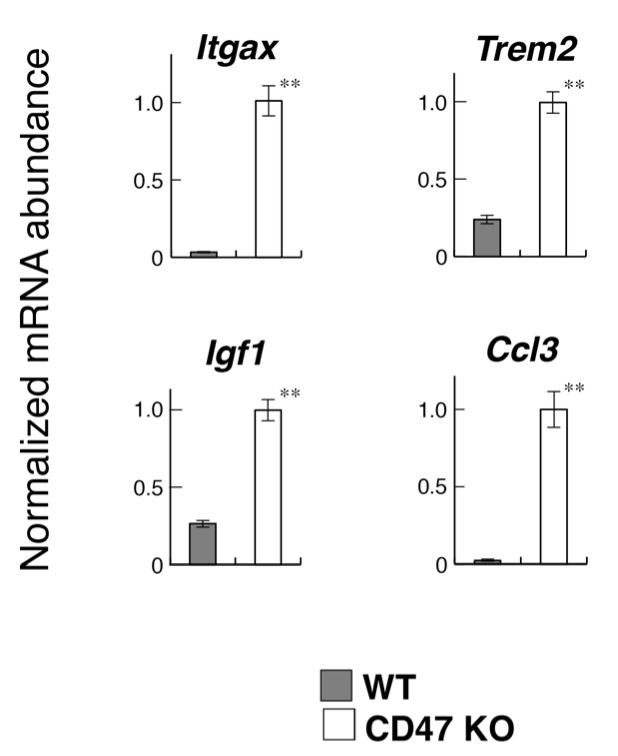
Quantitative PCR analyses of white matter RNA.Total RNA samples from the optic chiasm and optic nerve of CD47 KO and WT mice (n = 4 and 6, respectively) were subjected to quantitative PCR analysis to determine the expression levels of the indicated genes. The amount of each mRNA was normalised to that of glyceraldehyde-3-phosphate dehydrogenase (GAPDH) mRNA and presented relative to the mean value for control WT mice. Filled and open bars indicate WT and SIRPα KO mice, respectively. Data are the means ± SEM. **p<0.01 (Welch’s t-test).